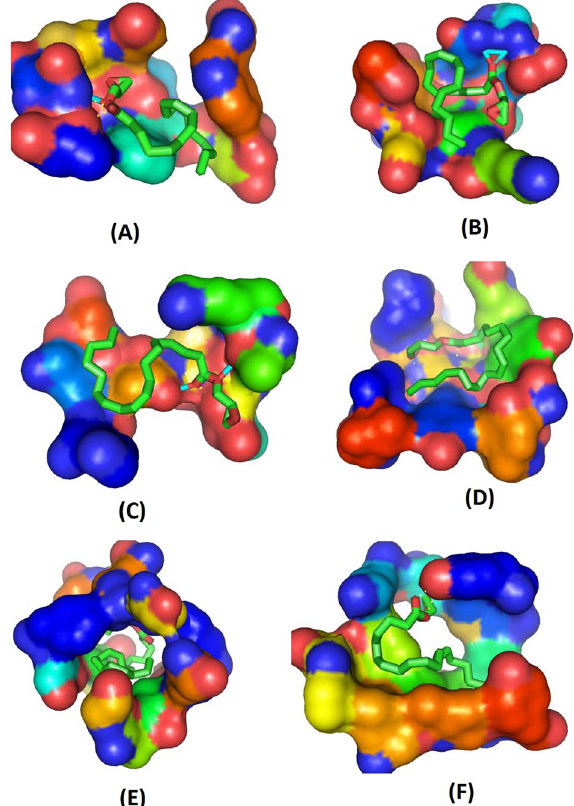
Fig. 8 3D surface interaction and conformation between Glyceryl diacetate-2-Oleate (Cp1) and six selected targets of Ruellia herbs. A Cp1 and CB2; B Cp1 and IL-1 β ; C Cp1 and IL-6; D Cp1 and TNF; E Cp1 and PTGS1; F Cp1 and DOPR. The blue colour indicates hydrogen bond interactions with side chain amino acid (mild polar) and pink represents the hydrophobic